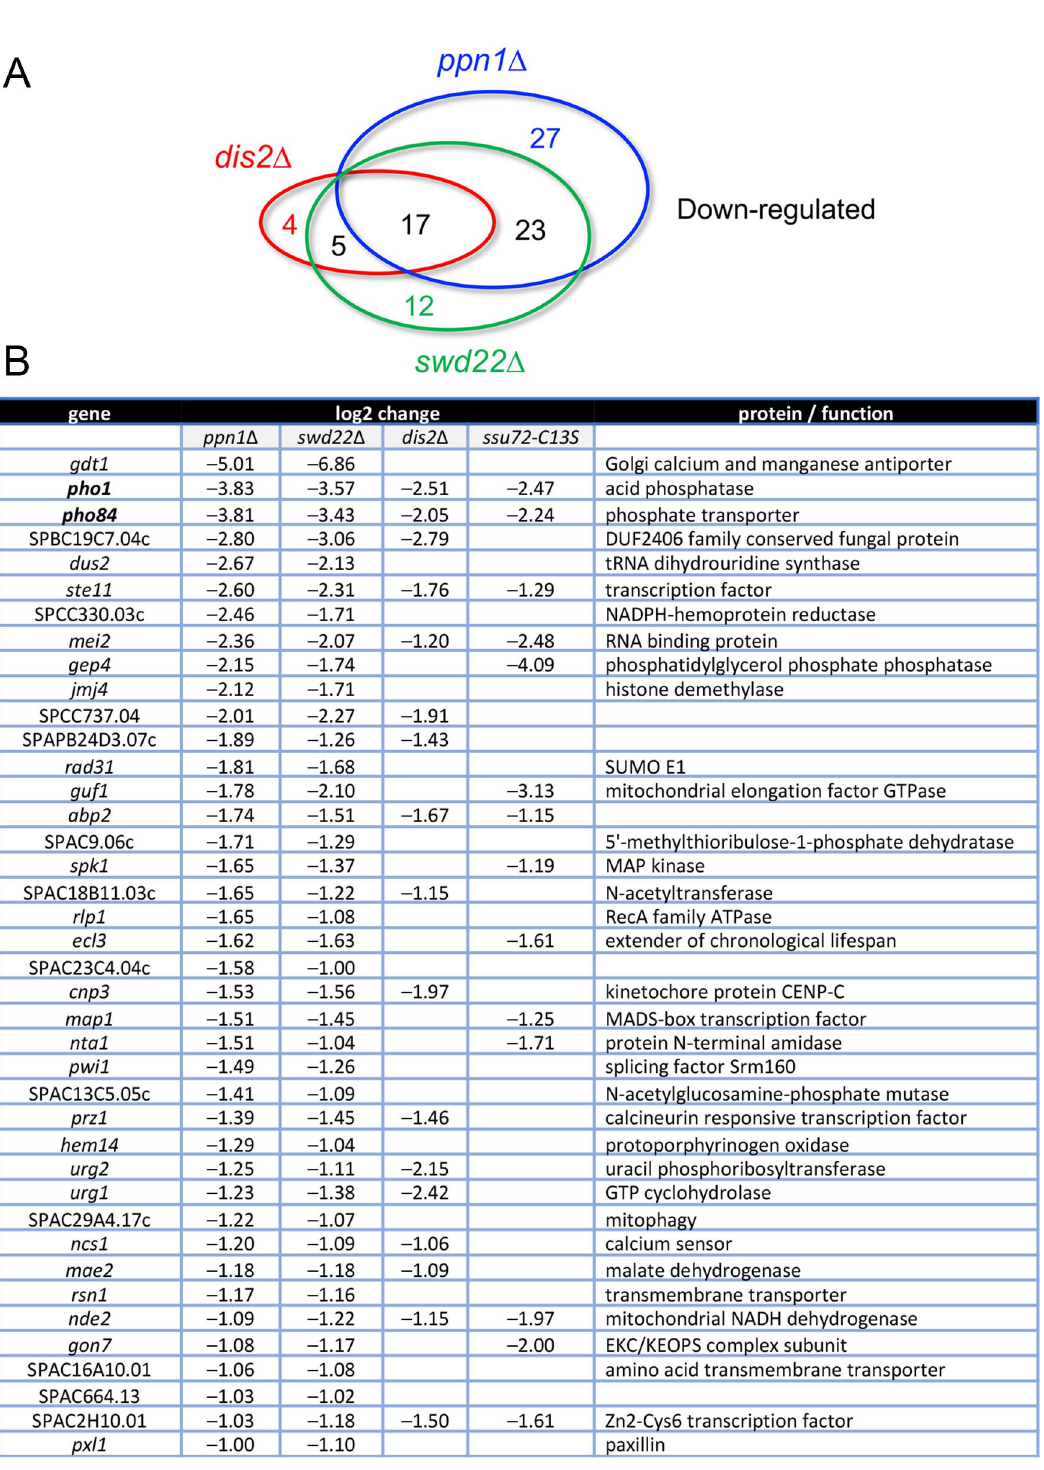
PLOS Genetics | https://doi.org/10.1371/journal.pgen.1009452 March 12,